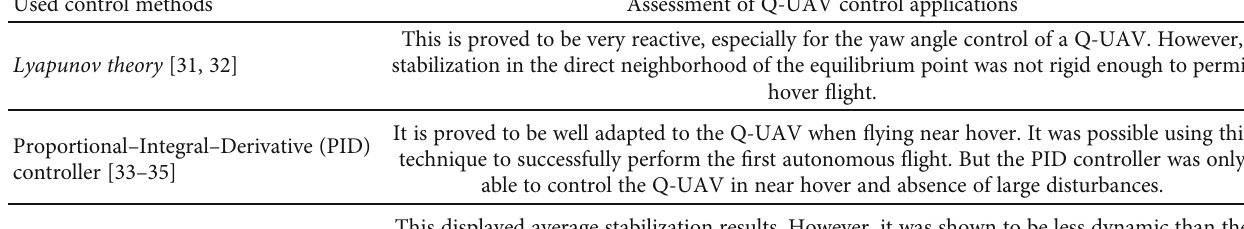
Table 1: Some of the used control methods and assessments for Quadrotor Unmanned Aerial Vehicle (Q-UAV) applications. Used control